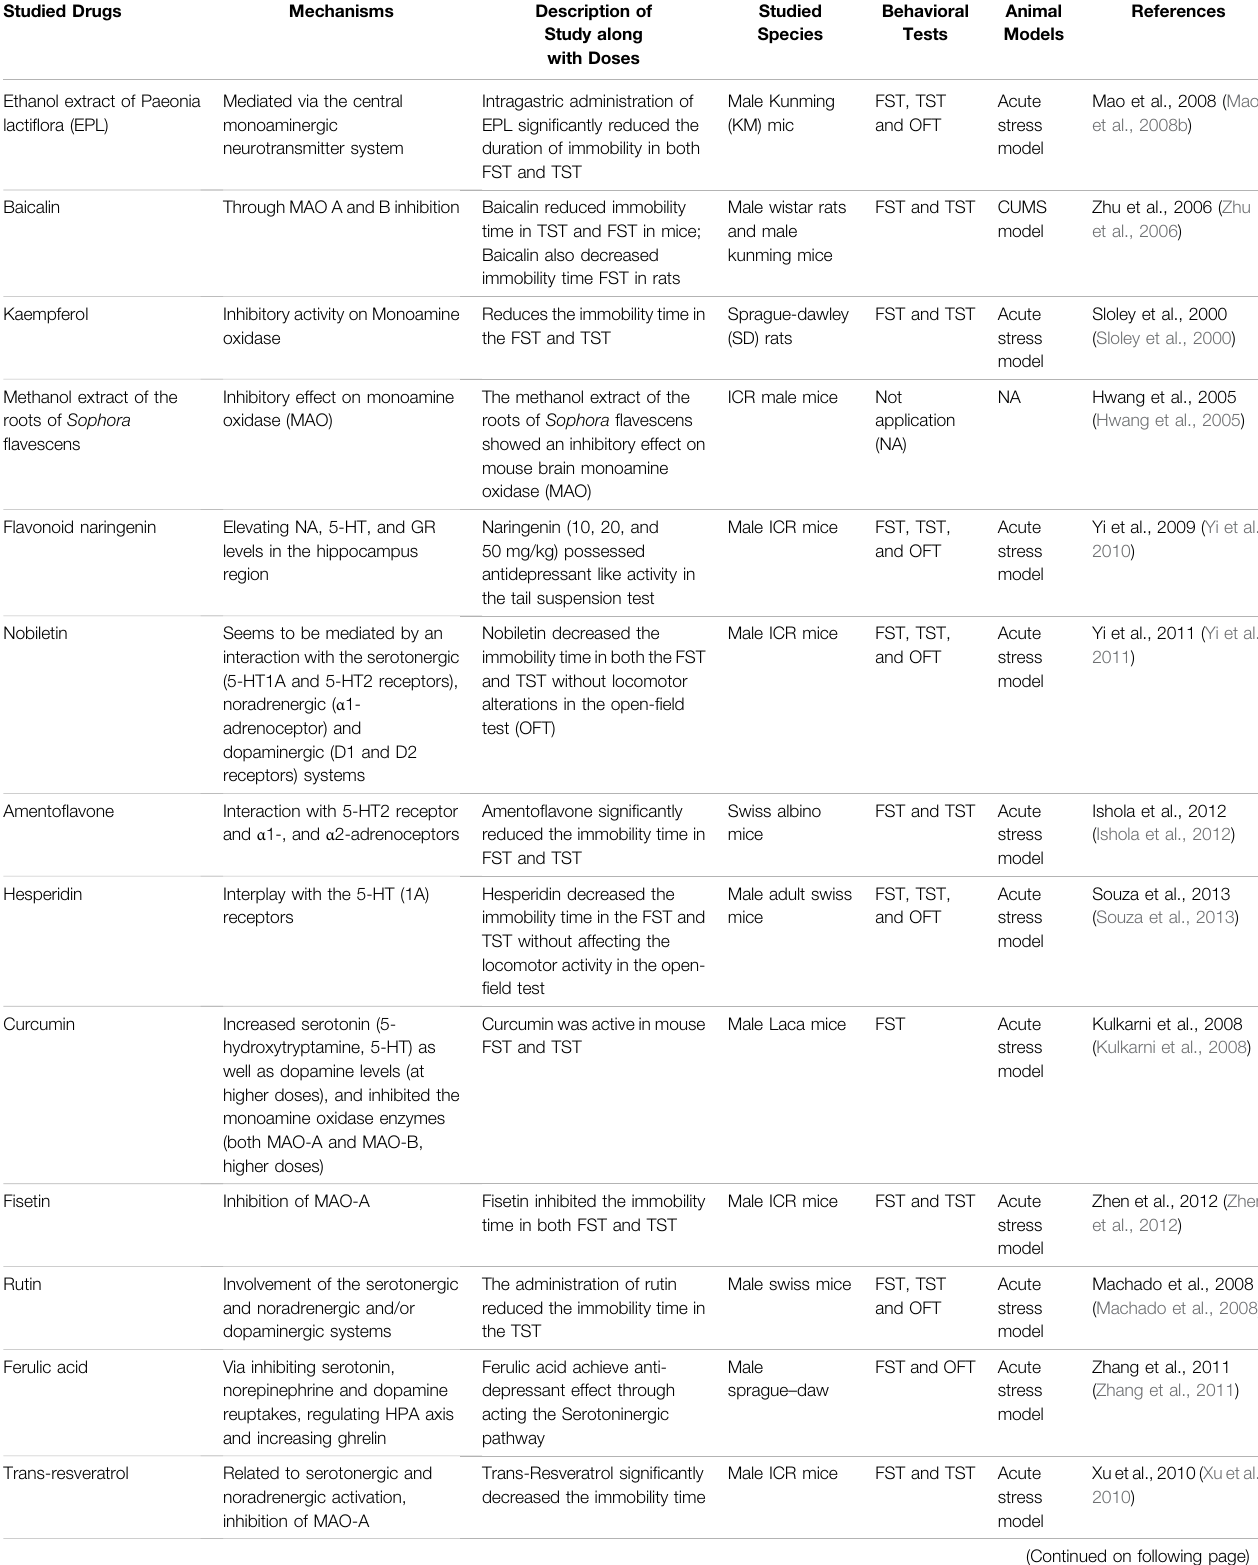
TABLE 1 | Potential natural products for the treatment of PSD by modulating neurotransmitters. Studied